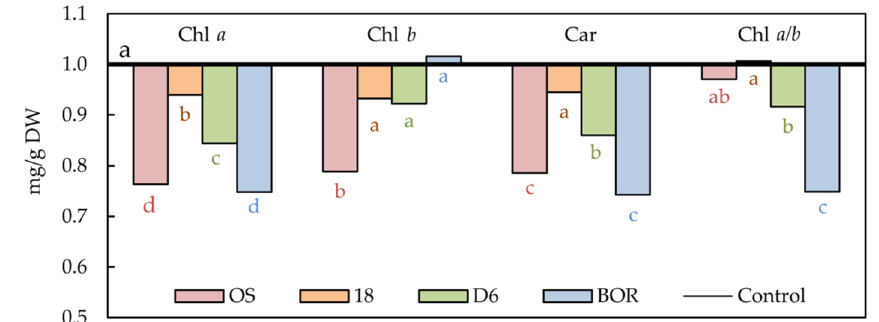
Figure 2. Photosynthetic pigments (Chl a , Chl b , Car, and Chl a / b ) in the leaves of Obla č inska sour cherry ecotypes (OS, 18, D6, and BOR) under control and drought conditions obtained at 8 days after stress (DAS). Normalized values of drought treatments according to control treatments are presented as mean values ( n = 5). Points labelled with different letters differ significantly at p < 0.05. Raw data are presented in Table S2.